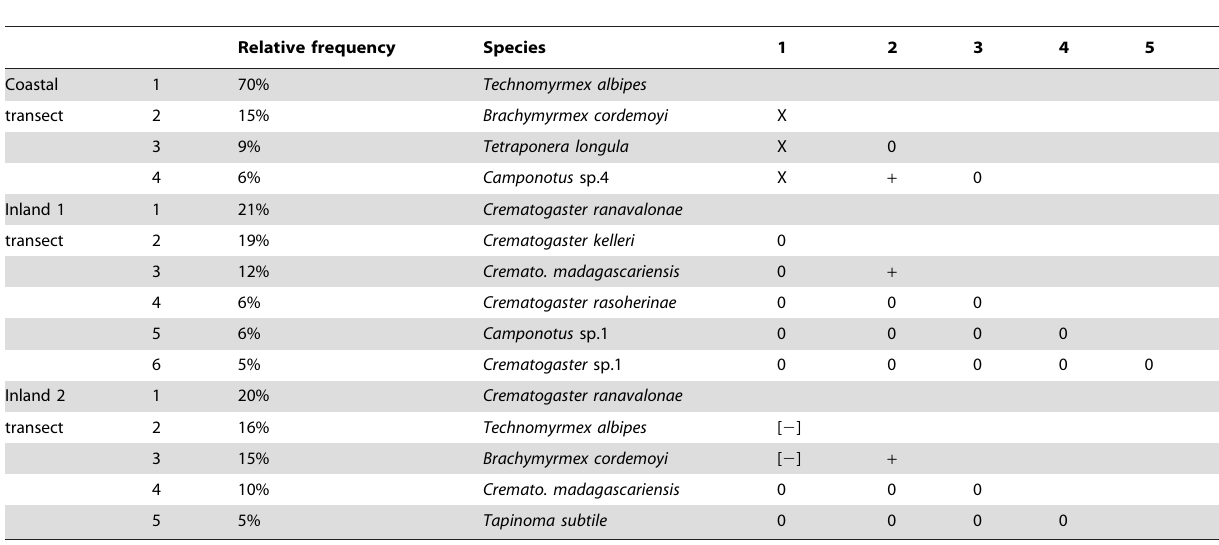
Table 2. Associations between the most frequent species (relative frequency . 5%) from the three transects sorted by decreasing rank of occurrence and tested using Chi -square tests (1 d.f., Yates’